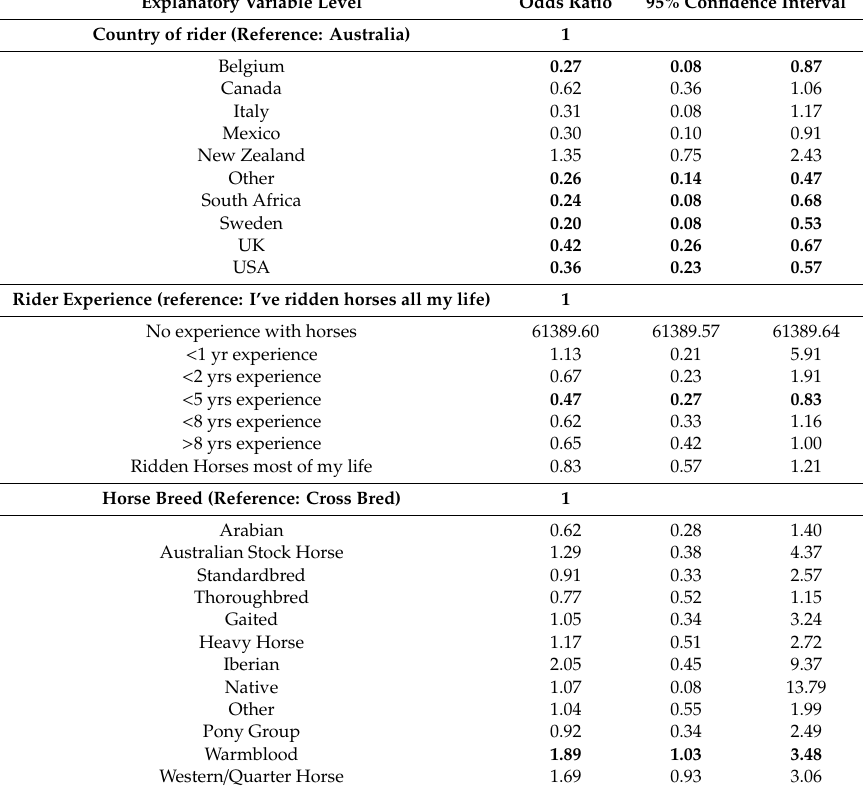
Table 4. Ordinal logistic regression results: Predictor variables, including the seven created predictor indices (rotated components), found to be associated with safety-from-bolt in owner reported n = 1584 horses. Significant values displayed in bold with odds ratio > 1 indicating increased safety-from-bolt and odds ratio < 1 indicating decreased